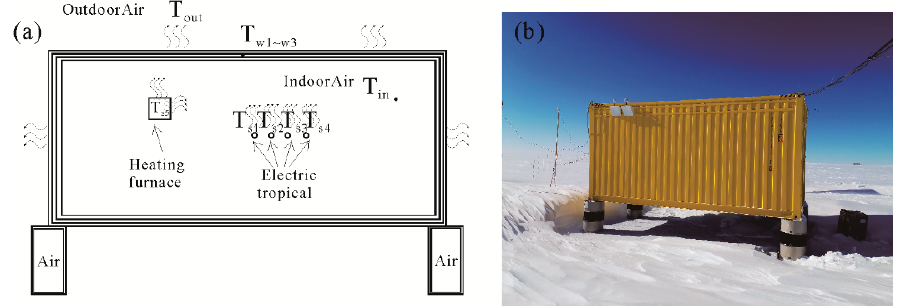
Figure 6. ( a ) The distribution of thermal nodes in the surface observation chamber. ( b ) The actual arrangement of the surface observation chamber at the Antarctic site in December 2019.